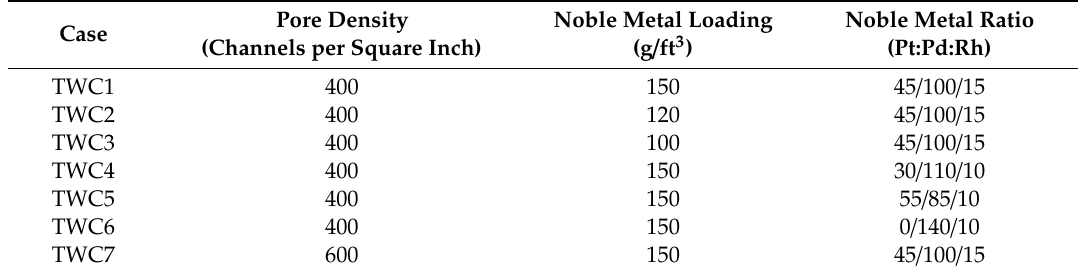
Table 3. The parameters of tested three-way catalysts